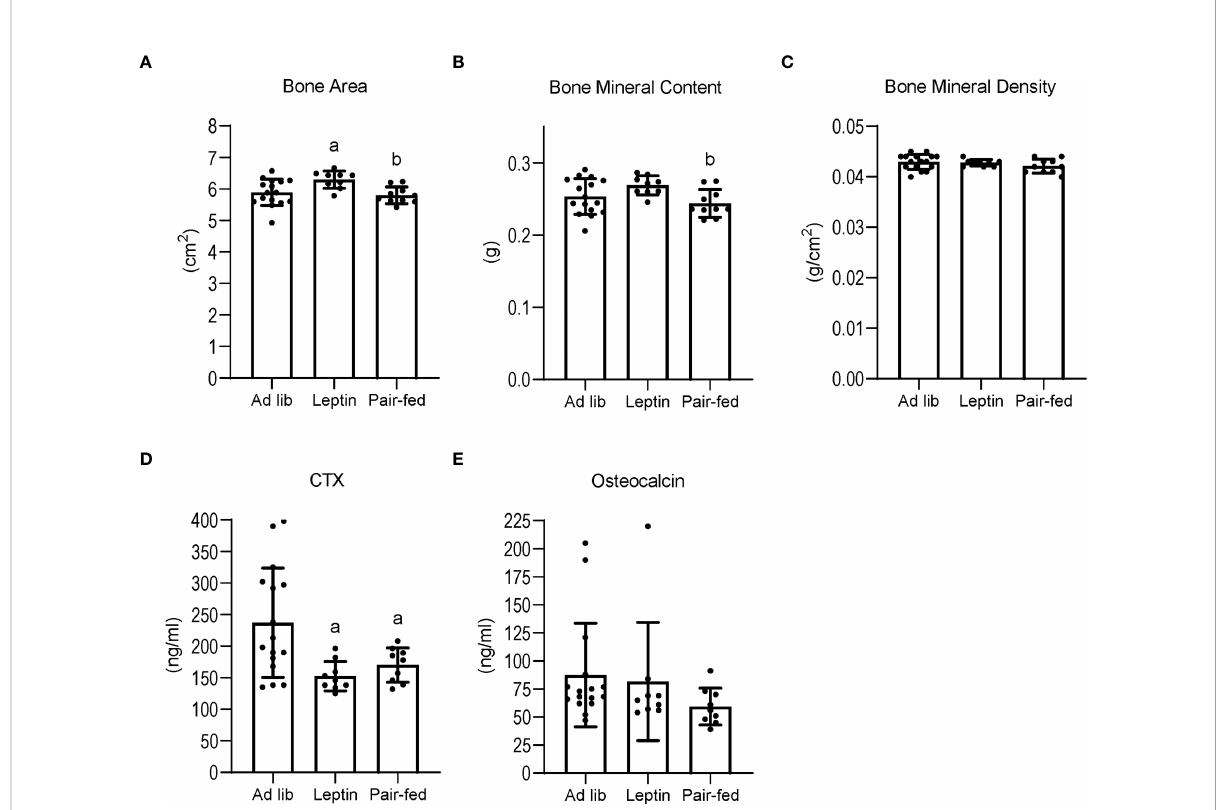
FIGURE 3 Effects of leptin supplementation and pair feeding on total body bone area (A) , bone mineral content (B) , and bone mineral density (C) , and on serum CTX, an index of global bone resorption (D) and osteocalcin, an index of global bone formation (E) in C57BL/6J female mice. Data are mean ± SD with individual data points shown as dots. N = 9-16/group for panels (A – E) Analysis of variance followed by appropriate posthoc tests was used to assess differences among groups. a Different from ad lib , FDR-adjusted P<0.05. b Different from leptin, FDR-adjusted